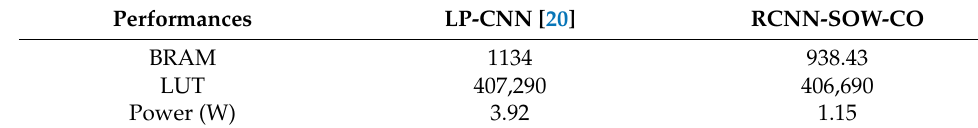
Table 12. Comparative analysis of RCNN-SOW-CO architecture for Virtex-7. Performances